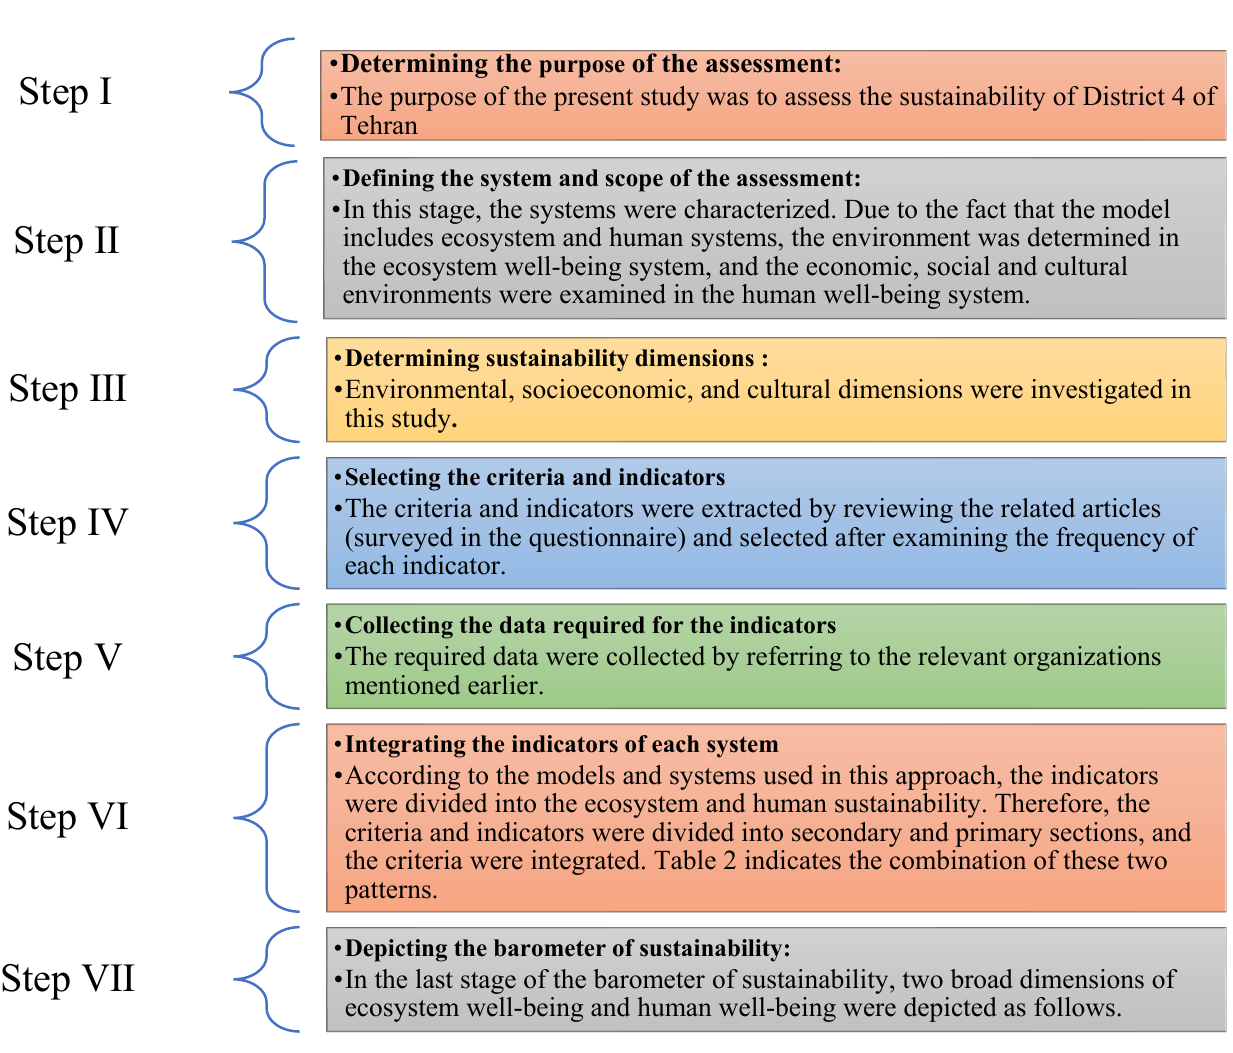
Figure 4. The egg of sustainability.